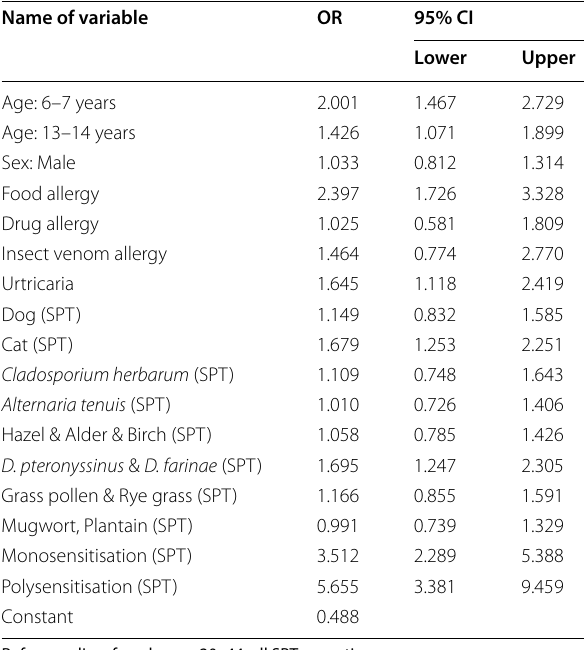
Fig. 6 The importance of sensitization to particular allergens (positive SPT Table 2 The influence of different parameters on multimorbidity (logistic